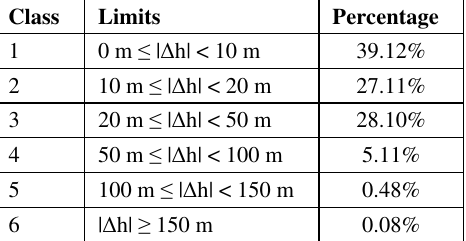
Table 4. Classes of elevation differences between Switzerland and Piedmont and their percentages